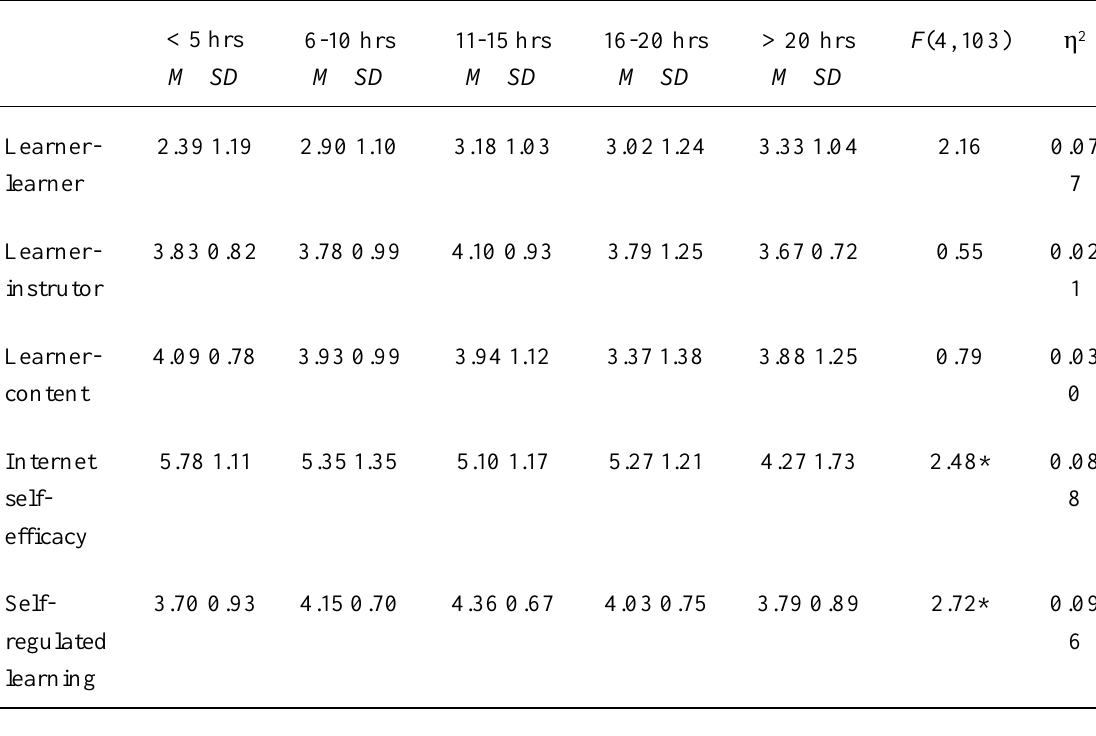
One-Way ANOVA of Hours Spent on Predictor